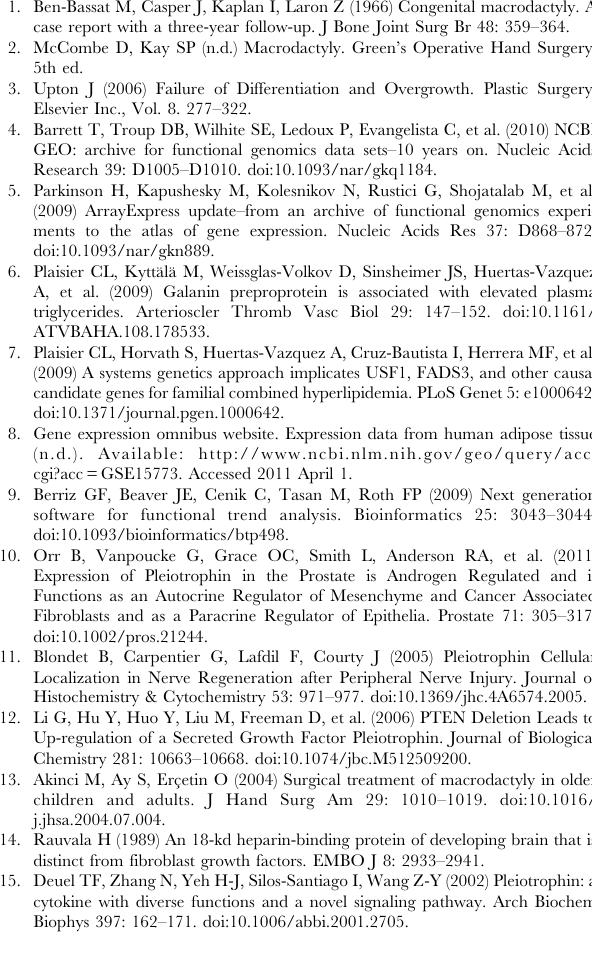
Table S1 Genes present in the ‘‘Response to Growth Factor Stimulus (GO:0070848)’’ gene ontology category. Table S2 Genes present in the ‘‘Extracellular Space (GO:0005615)’’ gene ontology category. Table S3 Genes present in the ‘‘Pattern Binding (GO:0001871)’’ gene ontology